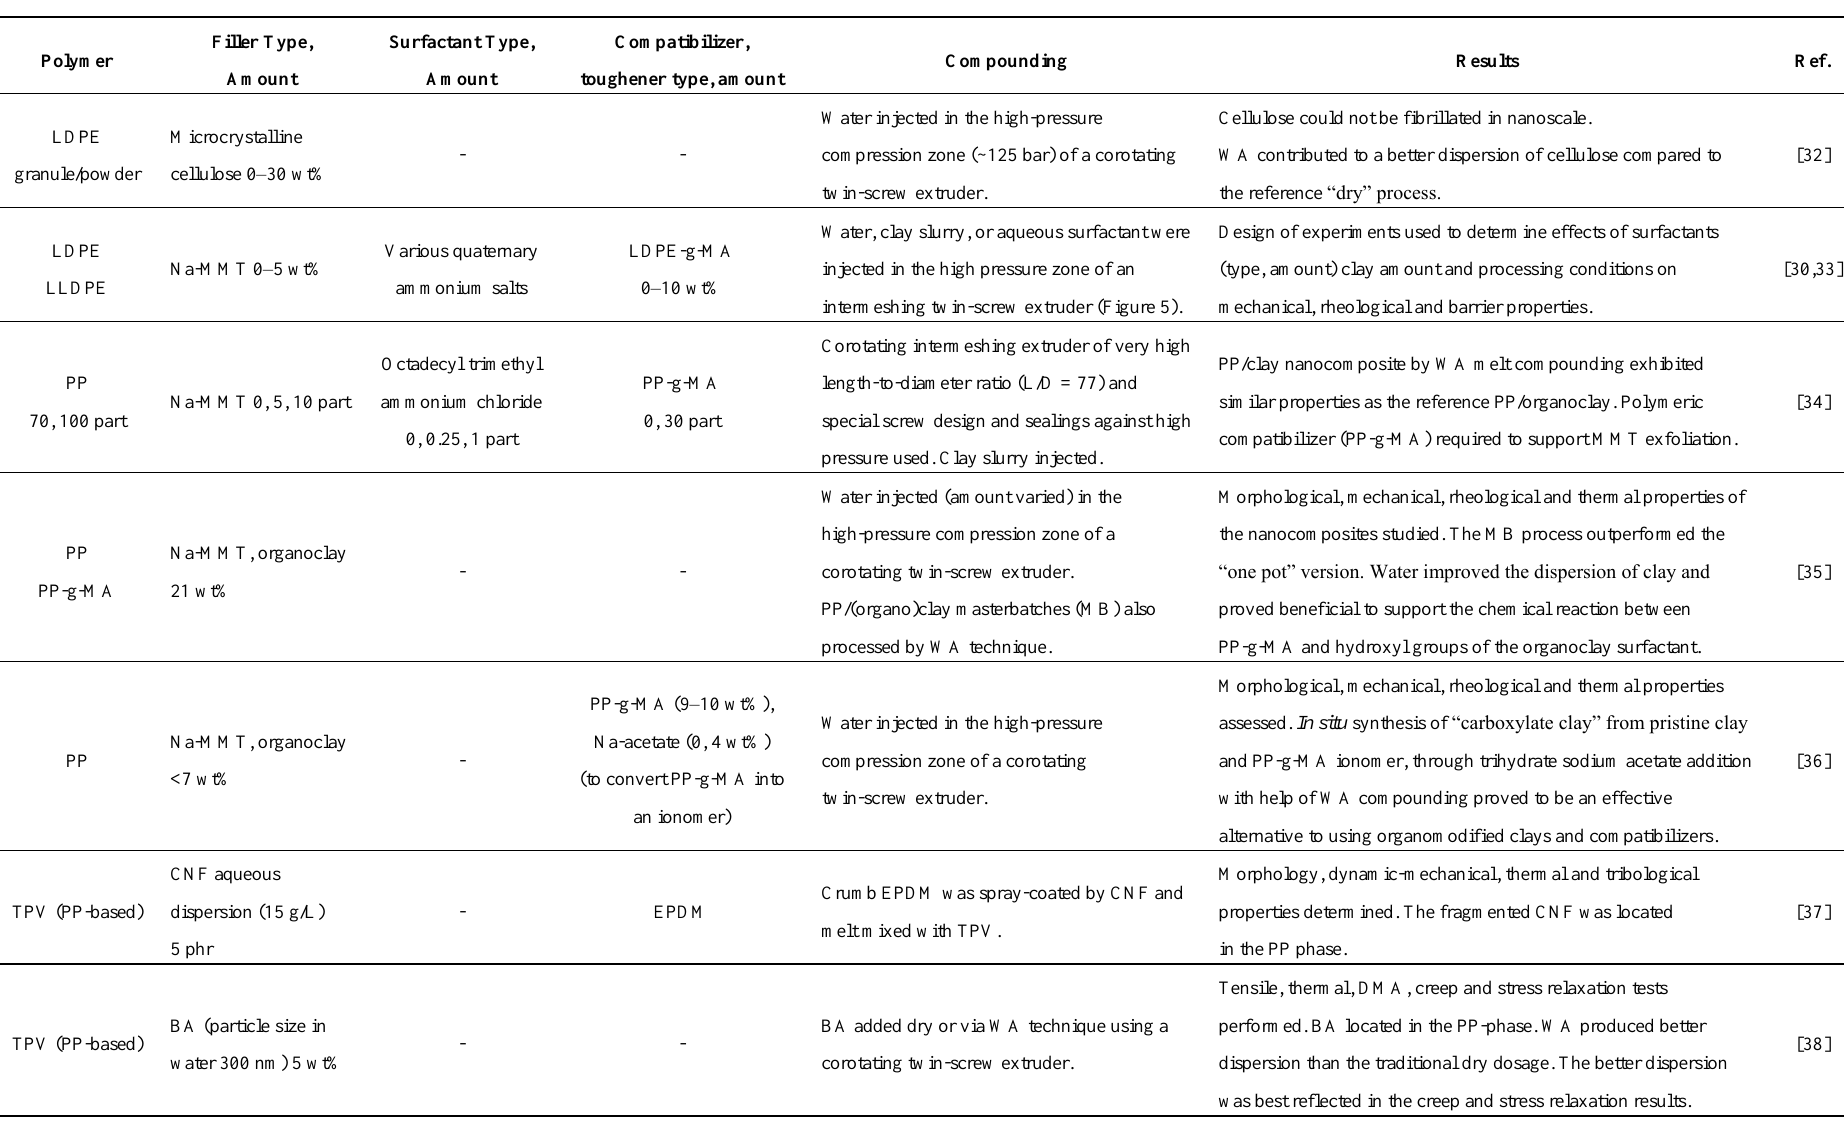
Table 1. Water-assisted (WA) melt compounding of commodity